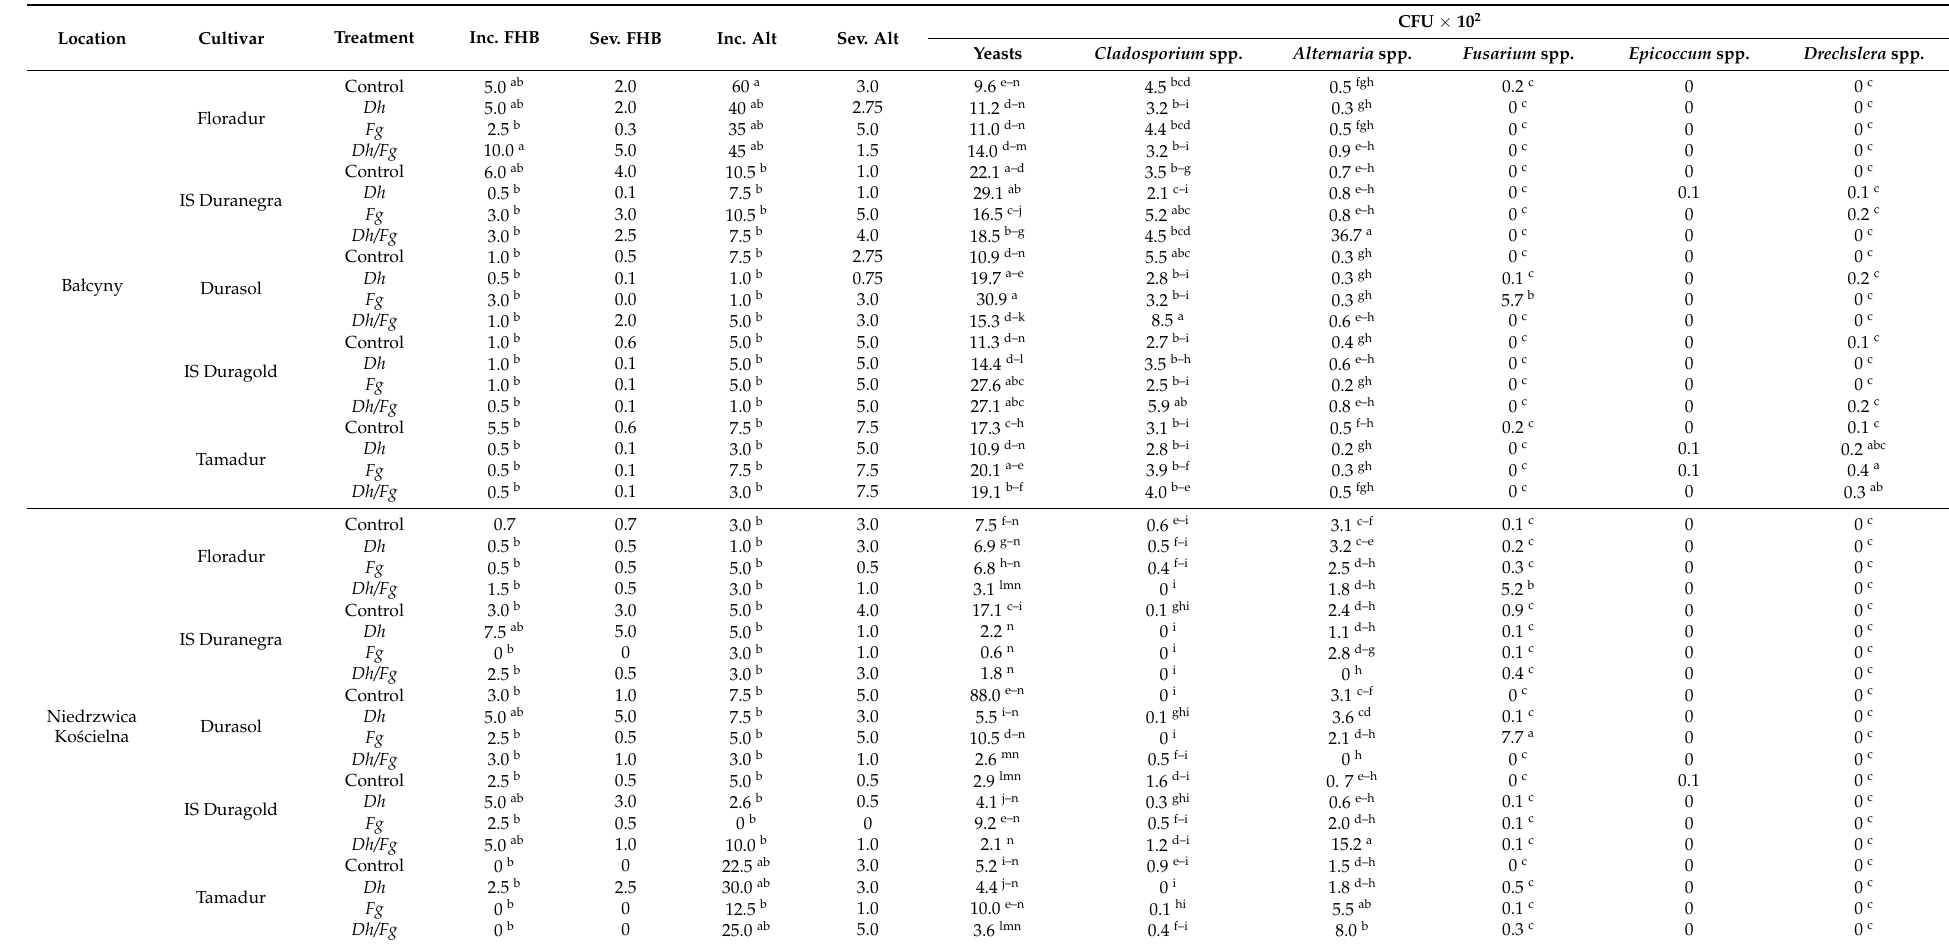
Table 3. The health status of spring durum wheat cultivars and mycobiota on